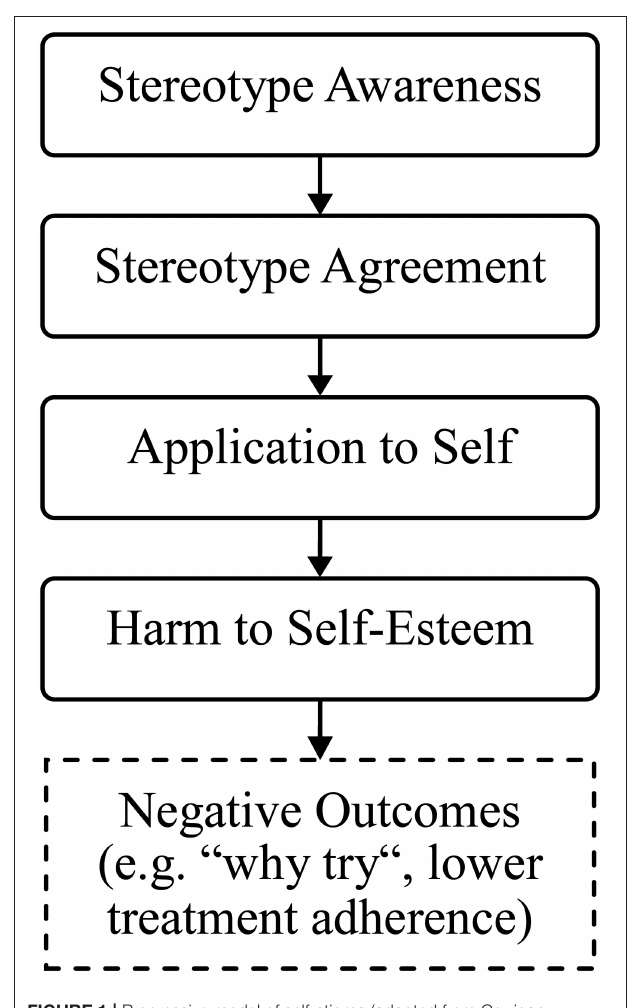
FIGURE 1 | Progressive model of self-stigma (adapted from Corrigan et al. (16)).